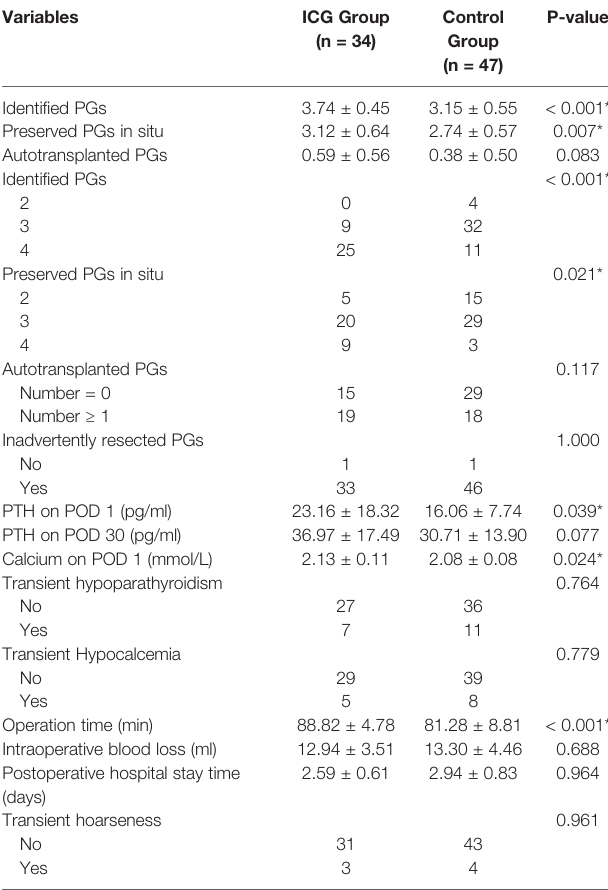
TABLE 2 | Surgical outcomes of the patients in the two groups. Variables ICG Group